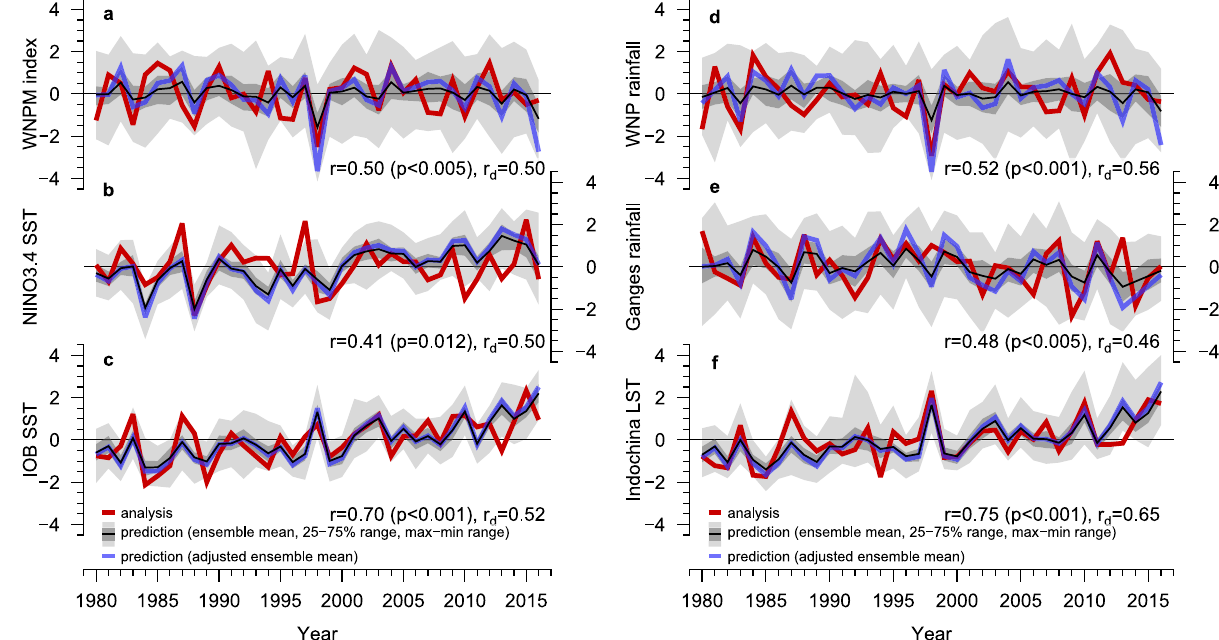
Fig. 1 Prediction skill for climate indices in the second summer. Time series of a the western North Paci fi c monsoon (WNPM) index, b NINO3.4 sea surface temperature (SST) index, c Indian Ocean Basin (IOB) SST index, d western North Paci fi c (WNP) rainfall index, e Ganges rainfall index, and f Indochina land surface (2 m air) temperature (LST) index (see Methods for de fi nitions). JMA/MRI-CPS2 ensemble mean predictions (thin black lines) and observations (thick red lines) are presented with a maximum – minimum and interquartile ranges of the ensemble predictions (grey shading). The ensemble mean predictions and observations are normalised by the mean and standard deviation of the concatenated all-member predictions and observations. Adjusted ensemble mean predictions (thick blue lines) are those normalised by the mean and standard deviation of the ensemble mean predictions. Correlation coef fi cients between the ensemble mean predictions and observations are shown at the bottom right (r raw time series, r d after linear